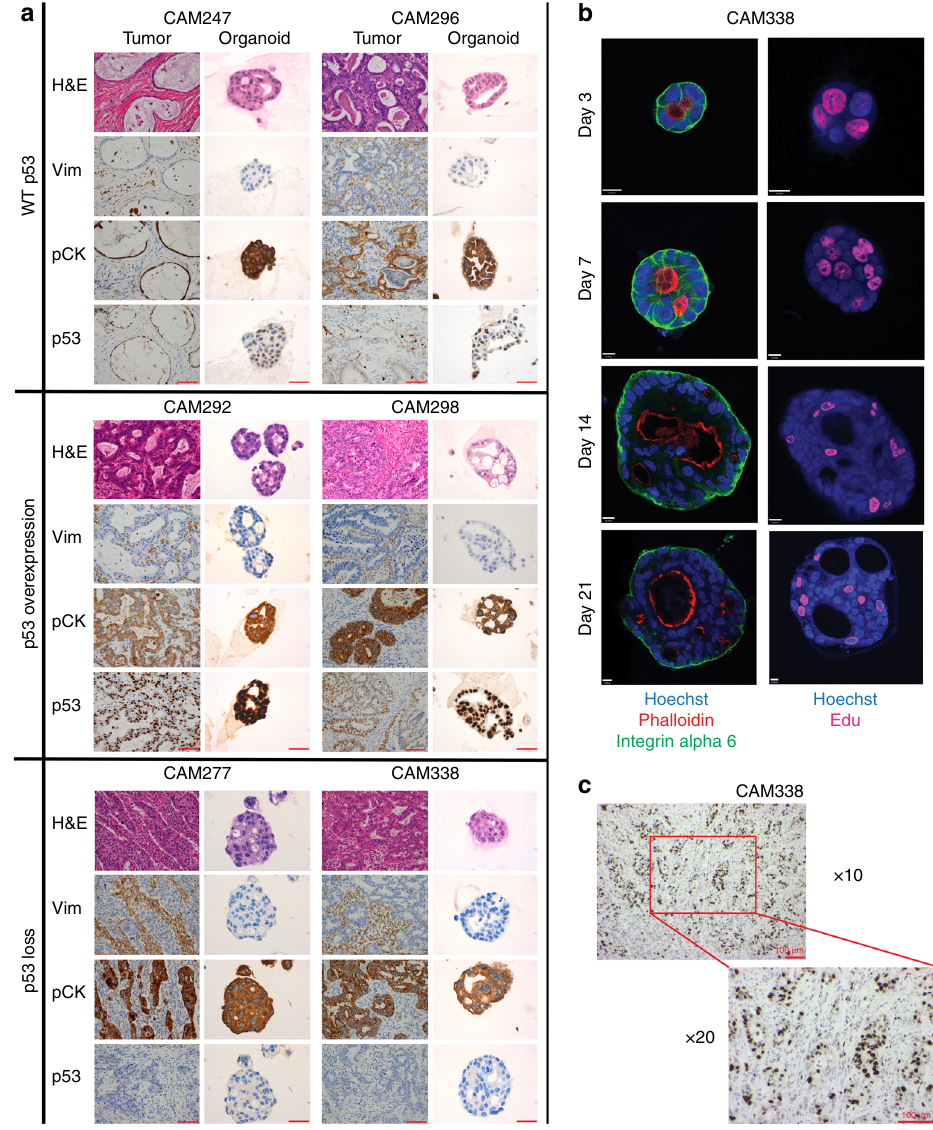
Fig. 1 Tumor organoid cultures share histopathological features with patient-matched tissue and disruption of polarity. a Representative images of H&E, and IHC of Vim (Vimentin), panCK (pan-cytokeratin), and p53 from primary tissue and patient-matched organoid (40× magni fi cation used for organoid models and 20× for tissues). Images are grouped by p53 expression pattern. Scale bar = 100 μ M in primary tissue images and 50 μ M in organoid images. b Representative whole-mount immunostaining images of tumor-derived organoids at days 3, 7, 14, and 21 after seeding, with anti-phalloidin (selectively stain F-actin, apical marker, Red), integrin α 6 (basolateral marker, green), Edu (proliferation marker, pink), and Hoechst (nuclei, blue) as indicated. Scale bar = 10 μ M. c Representative images of IHC of Ki67 from primary tumor tissue. Scale bar = 100 μ